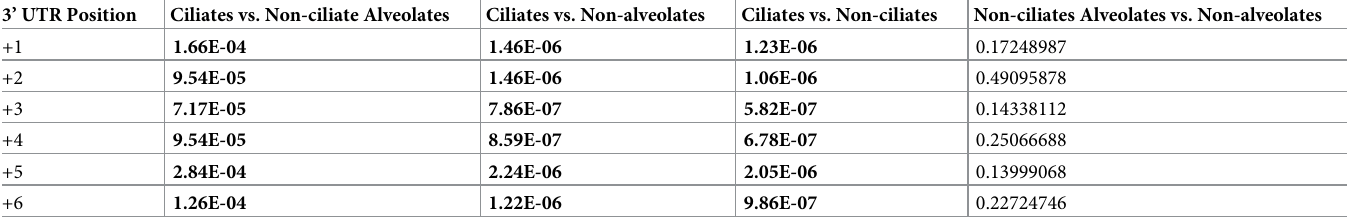
Table 1. Two-tailed Mann-Whitney non-parametric test comparing stop codon overrepresentation in 3’ UTRs across groups of species1. 3’ UTR Position Ciliates vs. Non-ciliate Alveolates Ciliates vs. Non-alveolates Ciliates vs.